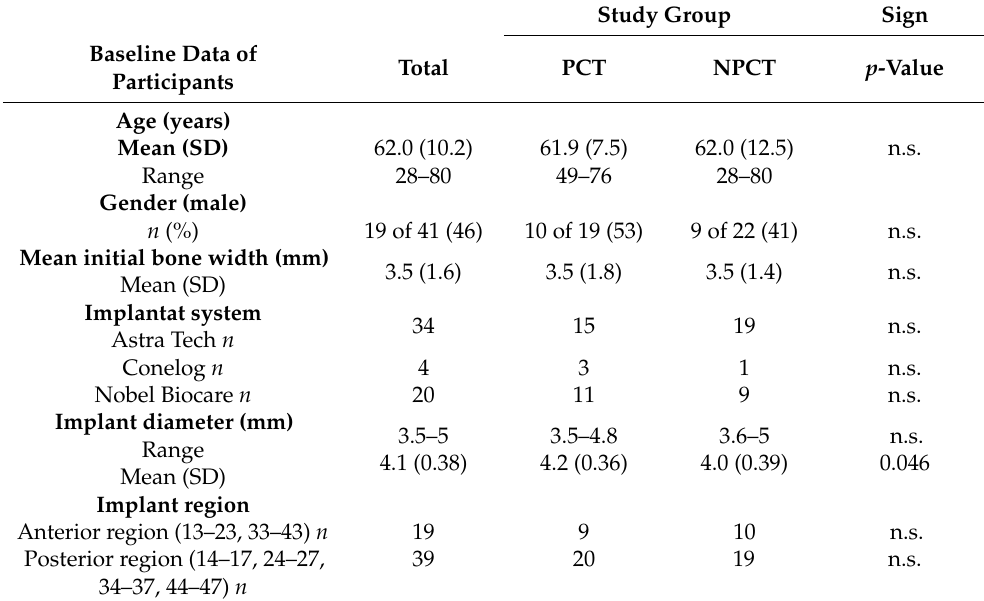
Table 1. Baseline data at the time of augmentation.